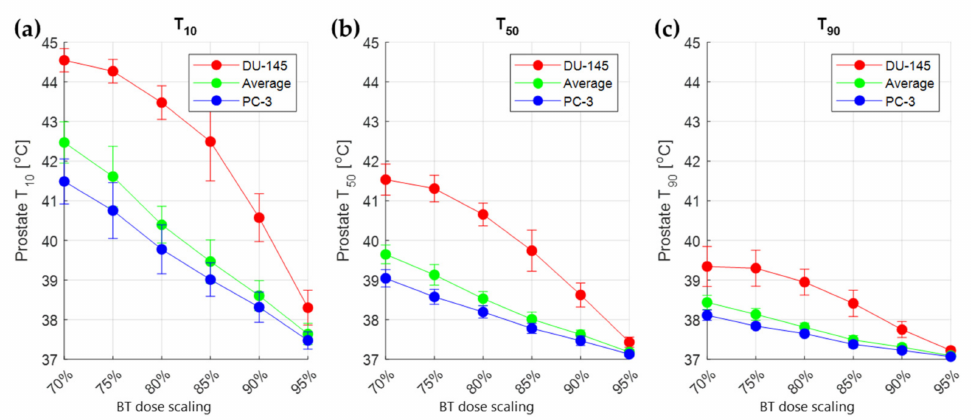
Figure 8. Average values ( ± standard deviation) over 10 simulated patients of the optimal TBT prostate T 10 ( a ), T 50 ( b ), and T 90 ( c ) for different scalings of the original HDR-BT dose. The different colors correspond to the plans generated based on different thermoradiotherapeutic values (red for DU-145, blue for PC-3, and green for the average between DU-145 and PC-3). The vertical bars correspond to standard